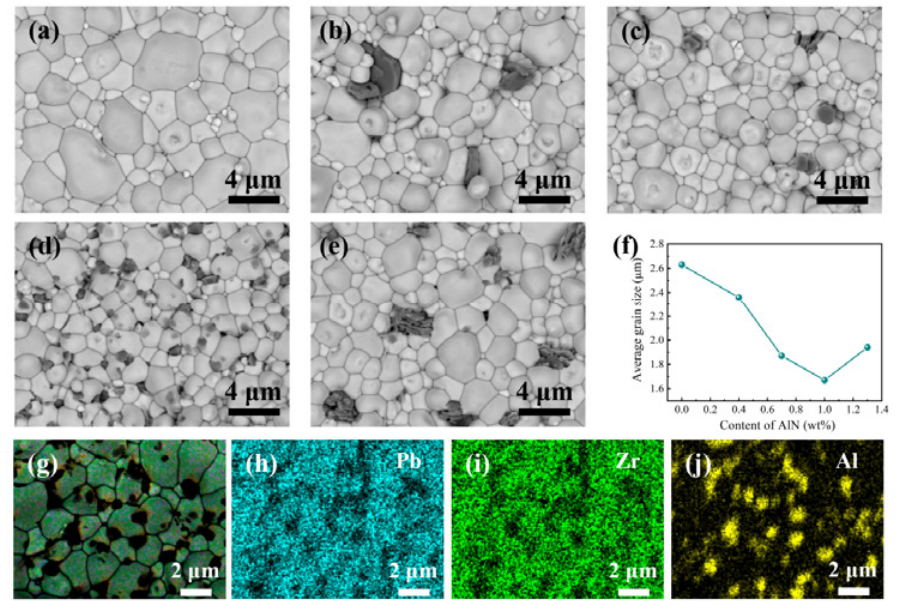
Fig. 2 (a)–(e) Surface SEM images of the PBLZST: x wt% AlN ceramics with x = 0, 0.4, 0.7, 1.0, and 1.3, respectively. (f) Average grain size of the materials with various content of AlN. (g) BSE image and EDS analysis of PBLZST:1.0 wt% AlN ceramics. The EDS mappings of (h) Pb, (i) Zr, and (j) Al.